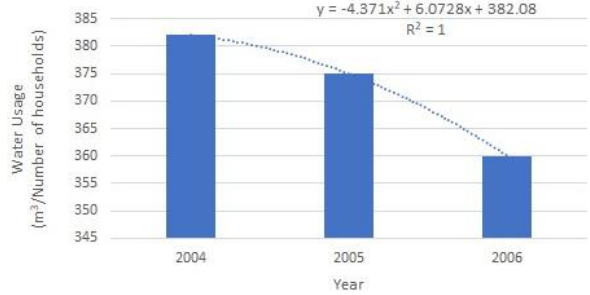
Fig. 5. Water use after implementation of progressive tariffs